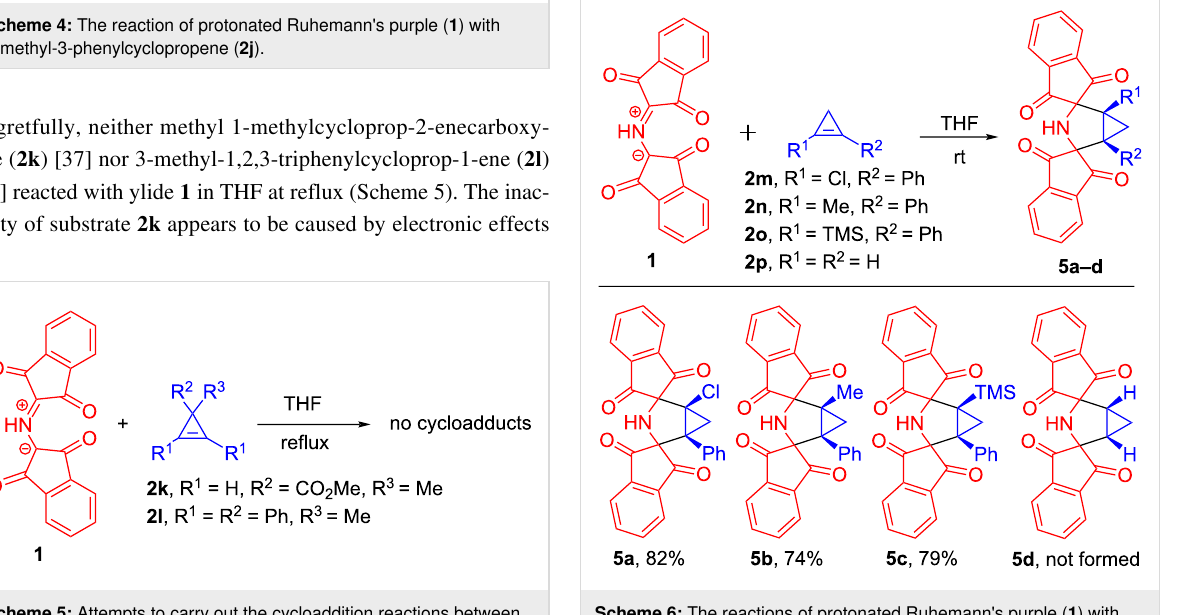
Scheme 5: Attempts to carry out the cycloaddition reactions between 3,3-disubstituted cyclopropenes 2k , l and azomethine ylide 1 .